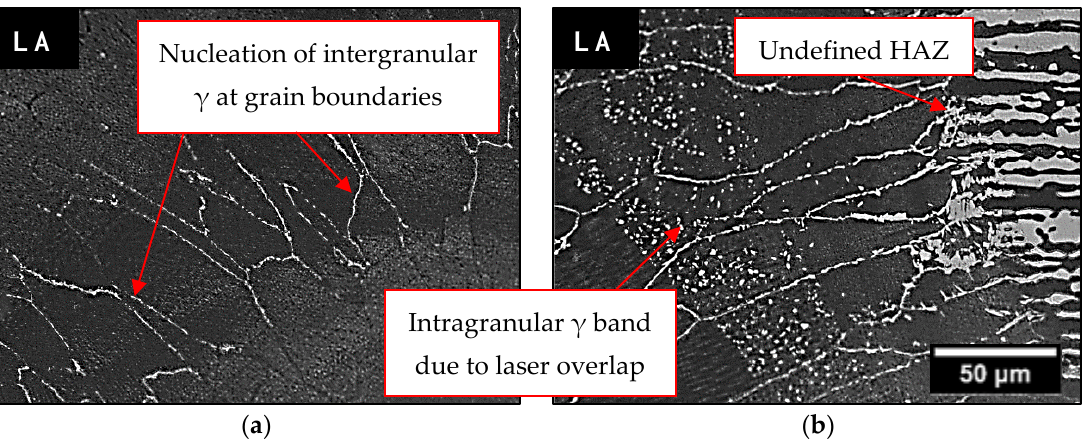
Figure 8. OM of LA weld bead showing ( a ) intergranular γ and ( b ) the effect of laser overlap on γ dispersion.